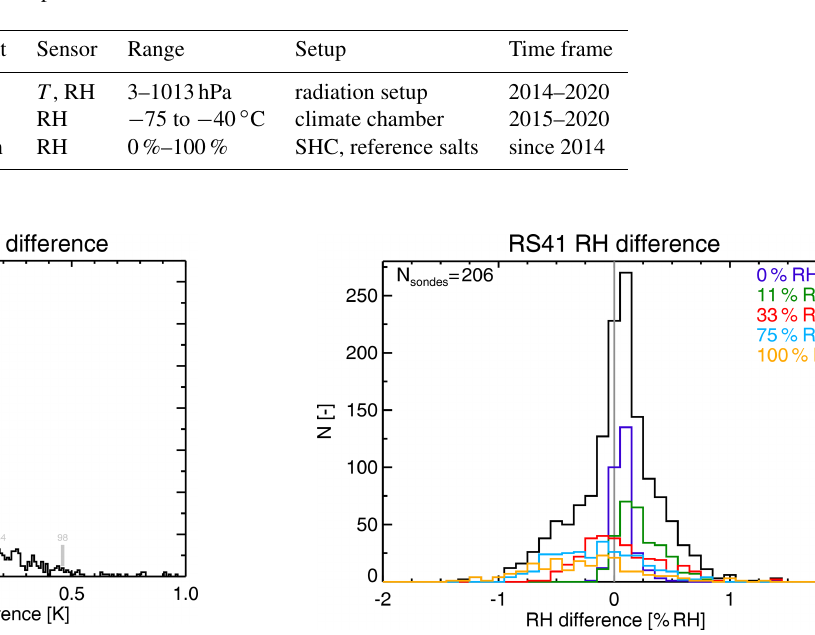
Figure 4. Histogram of the differences between the temperature recorded by the RS41 and the reference Pt100 probe at room tem- perature under various humidity conditions inside a standard hu- midity chamber. The plot displays the collated results for tests in RH environments of 0%RH, 11%RH, 33%RH, 75%RH, and 100%RH (Table 3) that were performed between 2014 and 2018. Data are collected in 0.01K bins. The grey bars indicate the per- centiles that correspond to the boundaries of the 1 σ (16 and 84) and 2 σ (2 and 98) ranges.